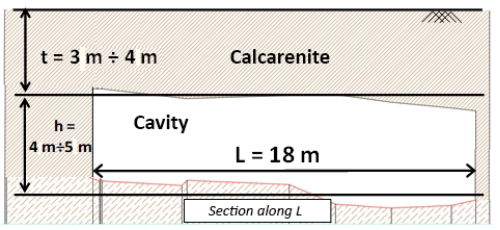
Figure 16. Cross section of the failed cavity in Gallipoli.